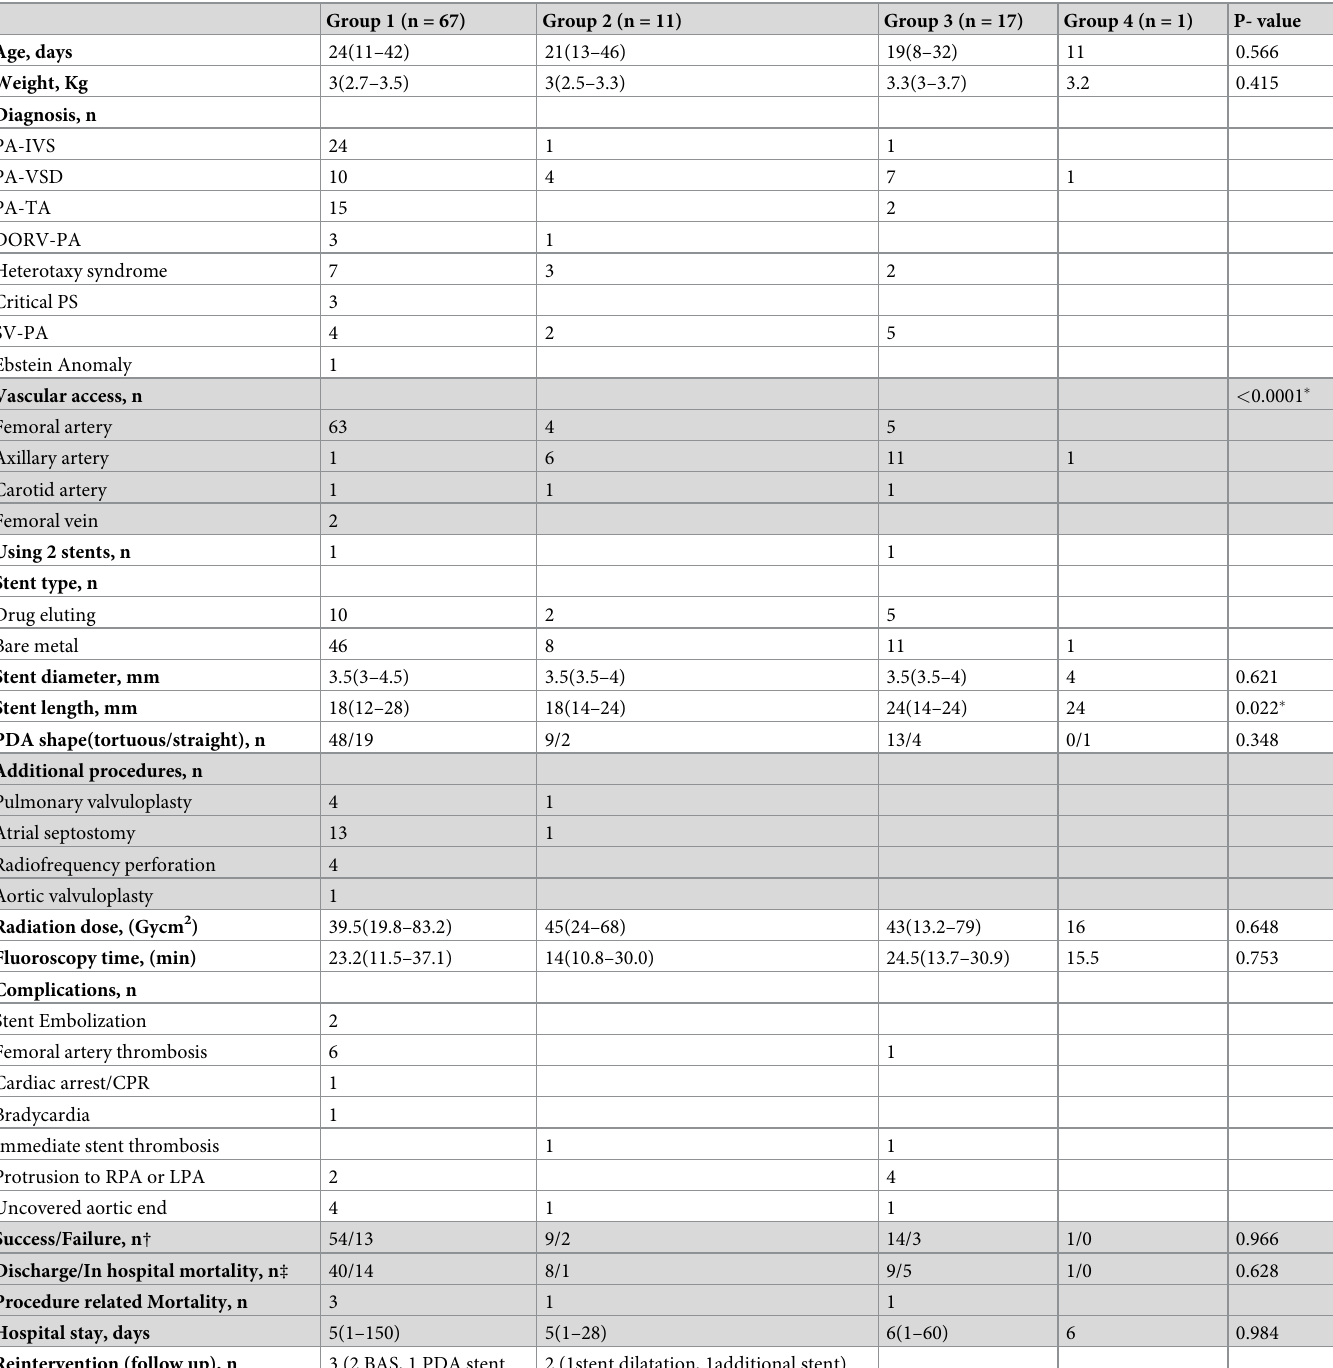
Table 1. Characteristics of patients 0 groups categorized based on PDA